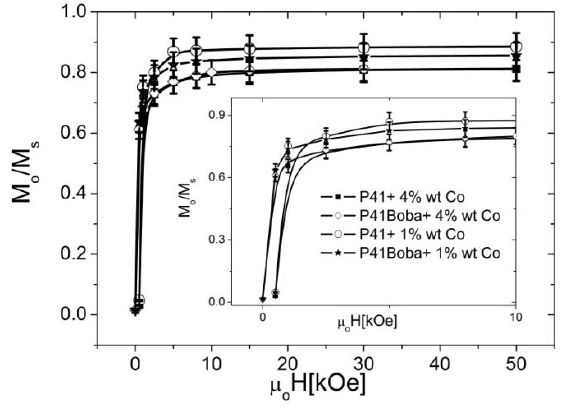
Figure 10. Initial magnetization divided by saturation magnetization as a function of the magnetic field applied during cooling from 400 K to 300 K in the case of different samples of P41 and P41Boba containing 1 wt% and 4 wt% Co